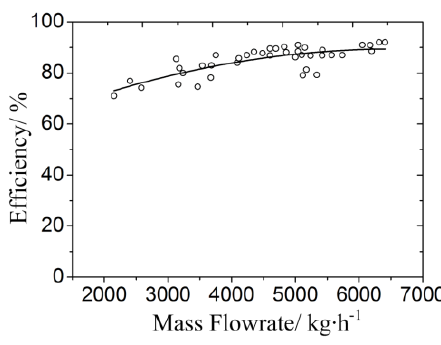
Figure 9. Thermal efficiency of